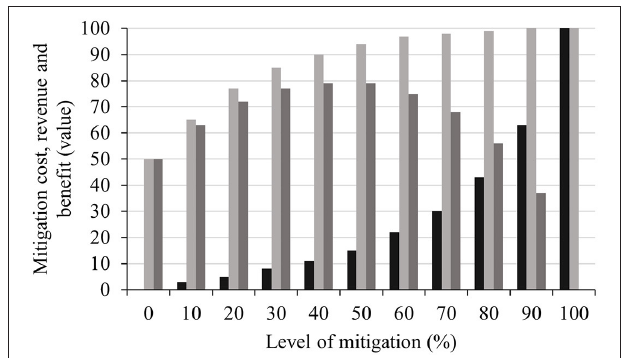
FIGURE 3 | Break-even heat stress mitigation metric based on data synthesised from Key et al. (2014). The level of mitigation and the values ( cost of mitigation revenue benefit) involved were set in a hypothetical (relative) range from 0 to 100. Benefits are relative to mitigation level and indicate the revenue value after deducting the cost of